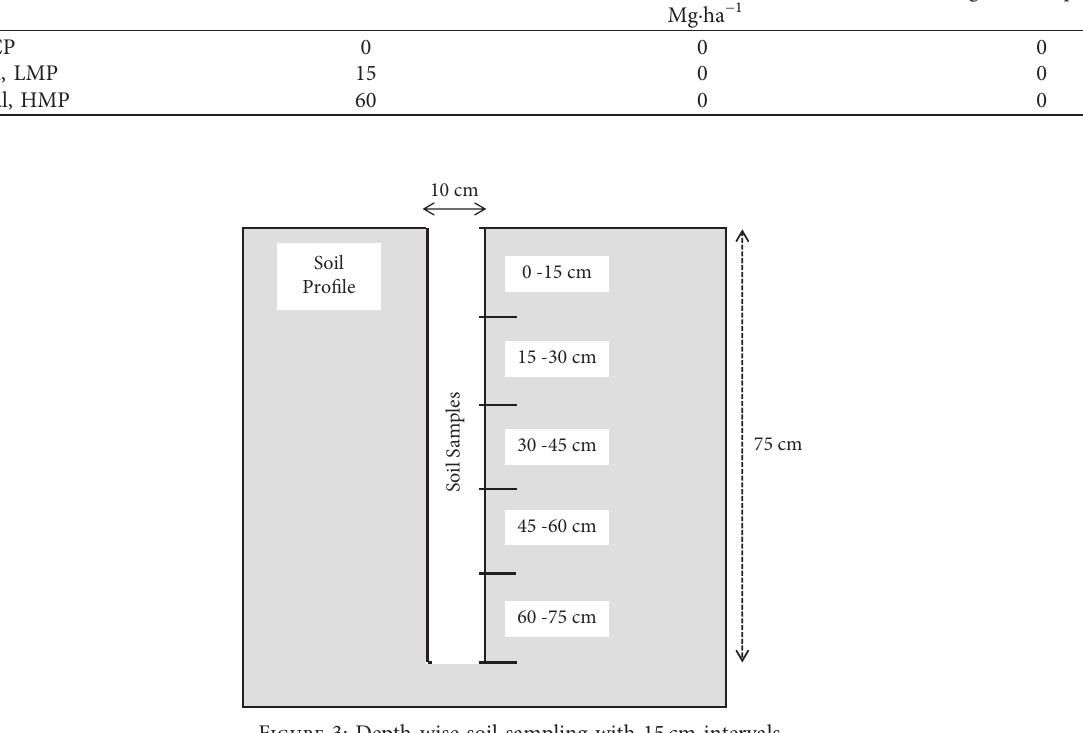
Table 2: The soil samples used in the evaluation of the Cu and Zn vertical and spatial distribution. Soil plot